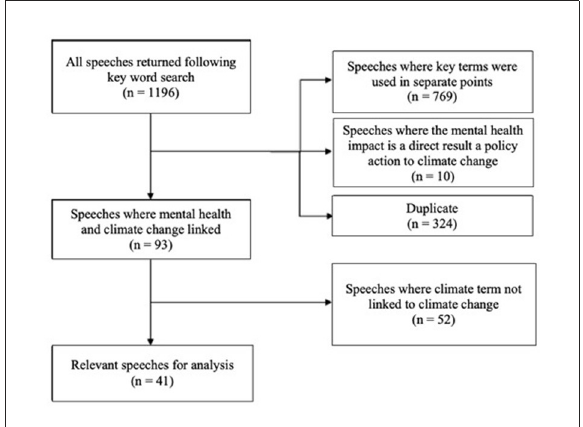
FIGURE1 Flow diagram outlining the identification of relevant speeches where climate change was linked to mental health. Duplicate speeches returned in multiple different searches as they contained multiple keywords were